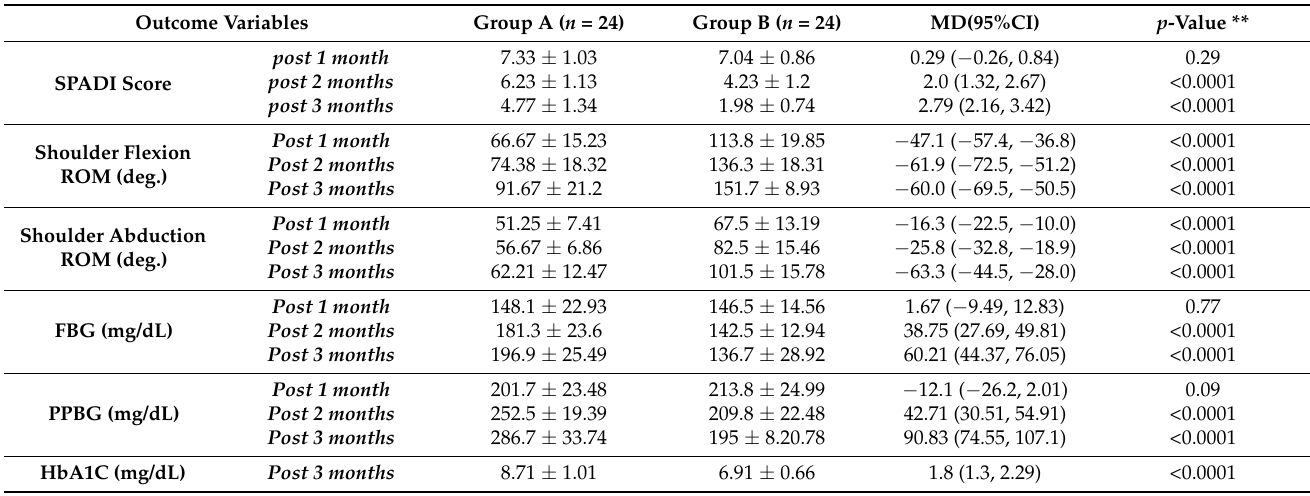
Table 1. Primary and Secondary Outcomes Data for 1-, 2-, and 3-months Follow-Up in Both Groups of the Study *. Outcome Variables